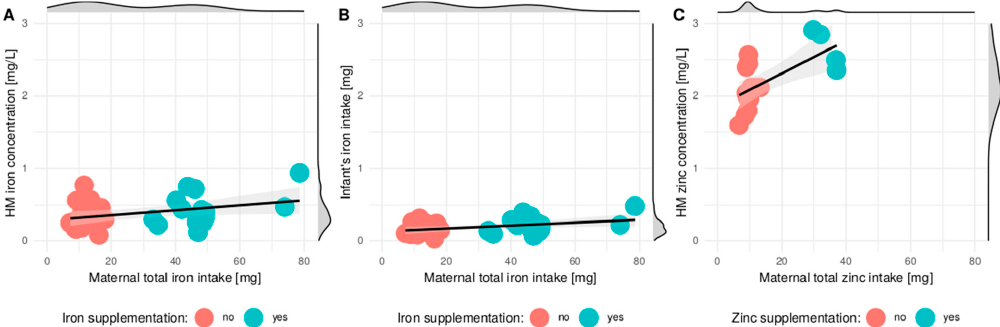
Figure 2. Correlation between total (dietary + supplemented) iron ( A , B ) or zinc delivery ( C ) and HM iron concentration ( A ), infant’s iron intake ( B ) and HM zinc concentration ( C ) according to the supplementation of iron or zinc. Density of HM iron/zinc concentration, infant’s iron intake, total iron intake and total zinc intake is presented at marginals of the plot. Linear regression lines with 95% confidence intervals were added to the